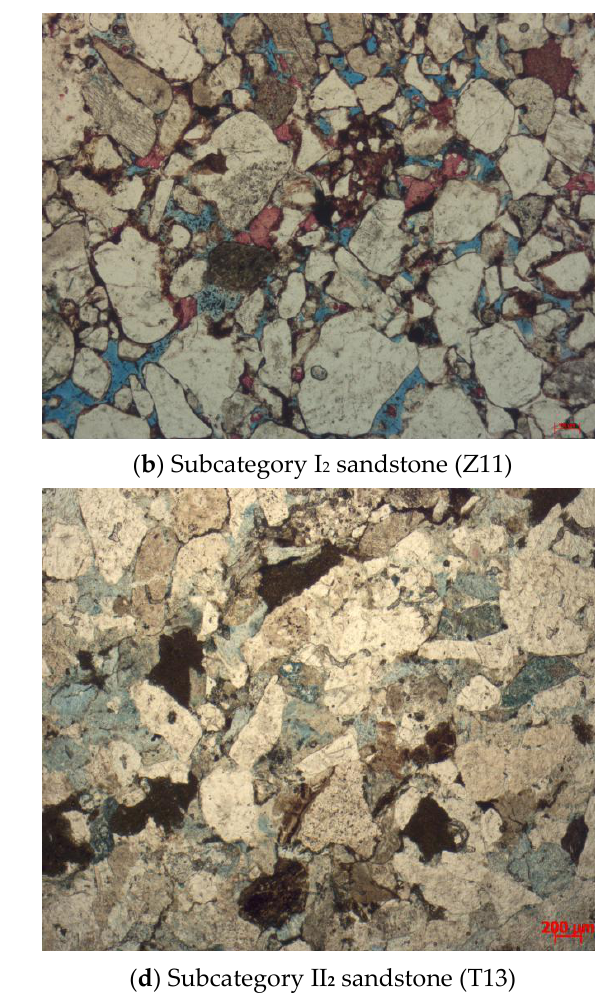
Figure 3. Comparisons of pores, throats and connectivities among the four subcategories of sandstone in casting thin slices under a polarizing microscope. (Note that the deep blue colors are mostly intergranular pores; the light blue colors are mostly intragranular pores and micropores).